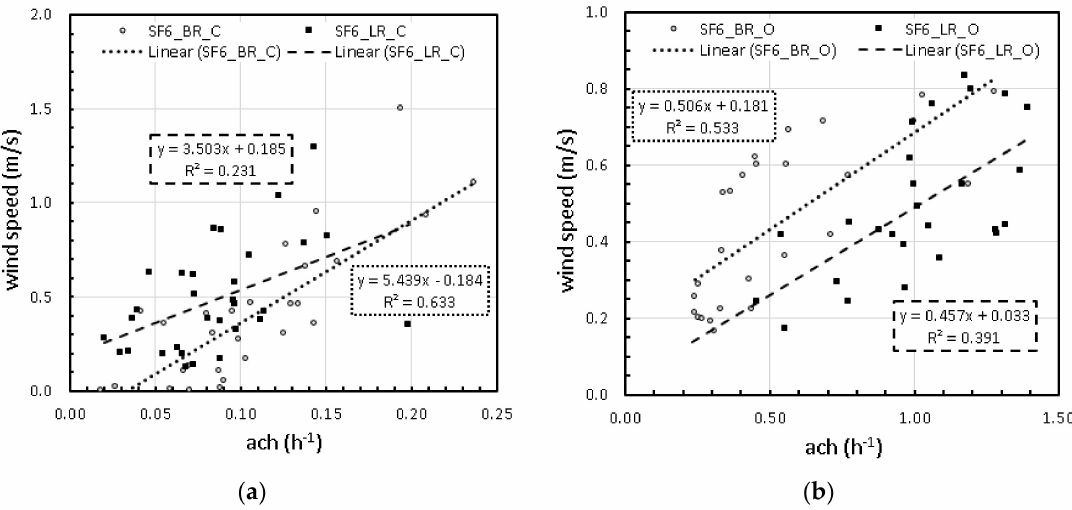
Figure 9. Air change rate versus wind speed: ( a ) Sulfur hexafluoride (SF 6 )—door closed; ( b ) Sulfur hexafluoride (SF 6 )—door